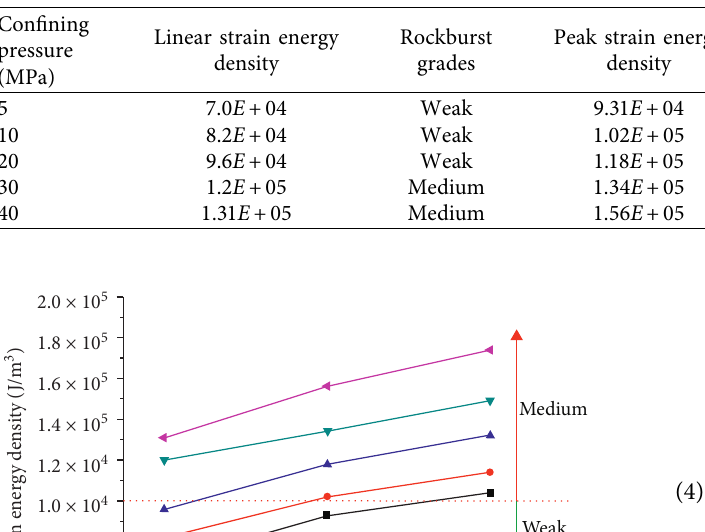
Table 2: Rockburst tendency under different confining pressures.